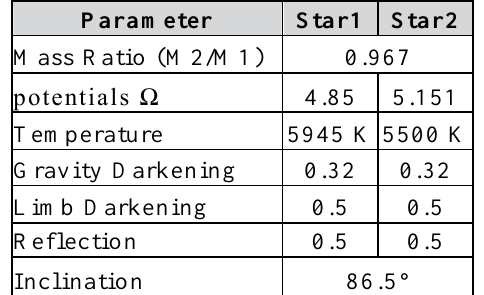
Table 4: The light curve fit parameters for BH Vir.